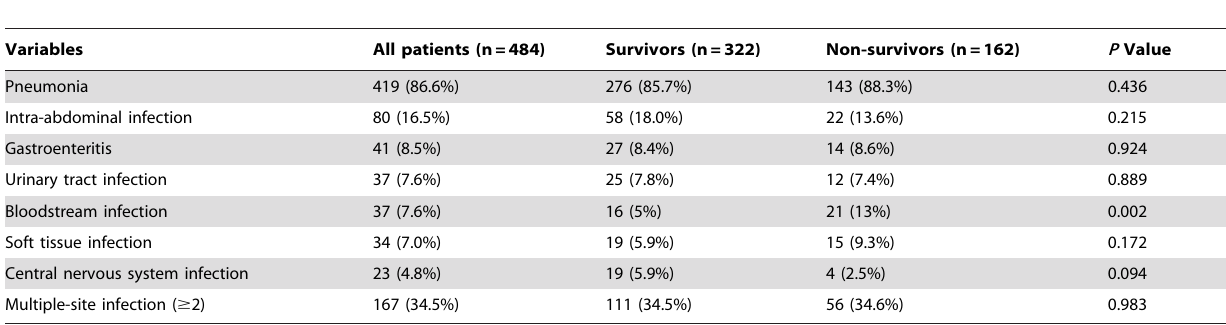
Table 3. The source of infection of patients with severe sepsis (total . 100% because 167 patients had more than one infection sites).